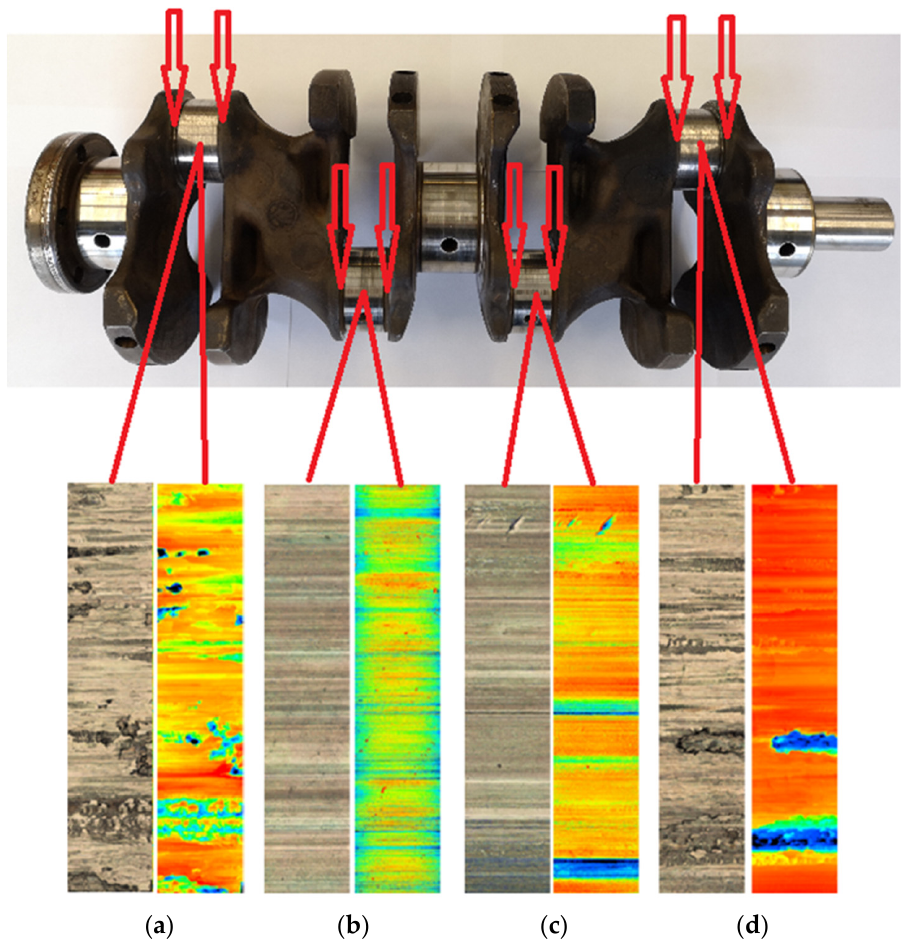
Figure 11. Analyzed areas of crankshaft roughness: ( a ) 1st cylinder; ( b ) 2nd cylinder; ( c ) 3rd cylinder; ( d ) 4th cylinder.